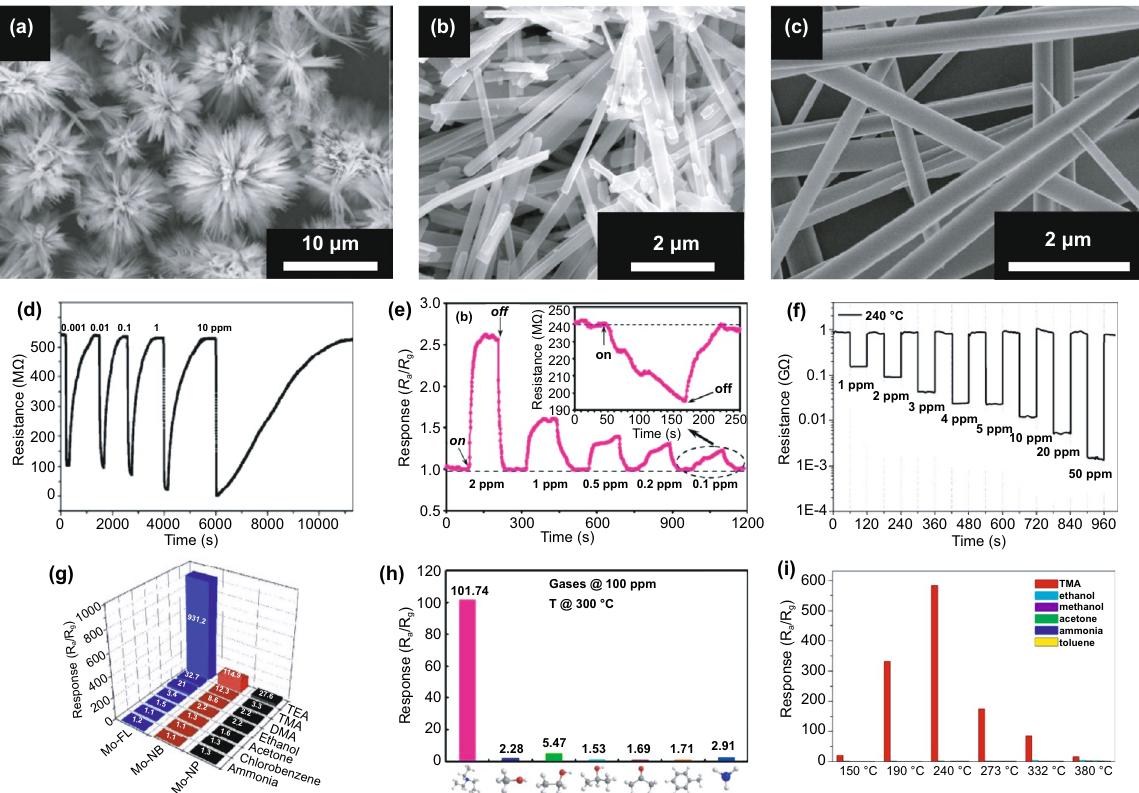
Fig. 3 α-MoO 3 flower-like showing superior TEA sensor performance at 170 °C ( a, d, g ) compared to α-MoO 3 nanorod that has optimal tem- perature of 300 °C ( b, e, h ) and α-MoO 3 nanobelts that have optimal temperature of 240 °C ( c, f, i ). ( a, d, g ) are reproduced with permission from Ref. [87]. Copyright 2015, The Royal Society of Chemistry. ( b , e , h ) are reproduced with permission from Ref. [78]. Copyright 2019, Else- vier. ( c , f , i ) are reproduced with permission from Ref. [26]. Copyright 2016,